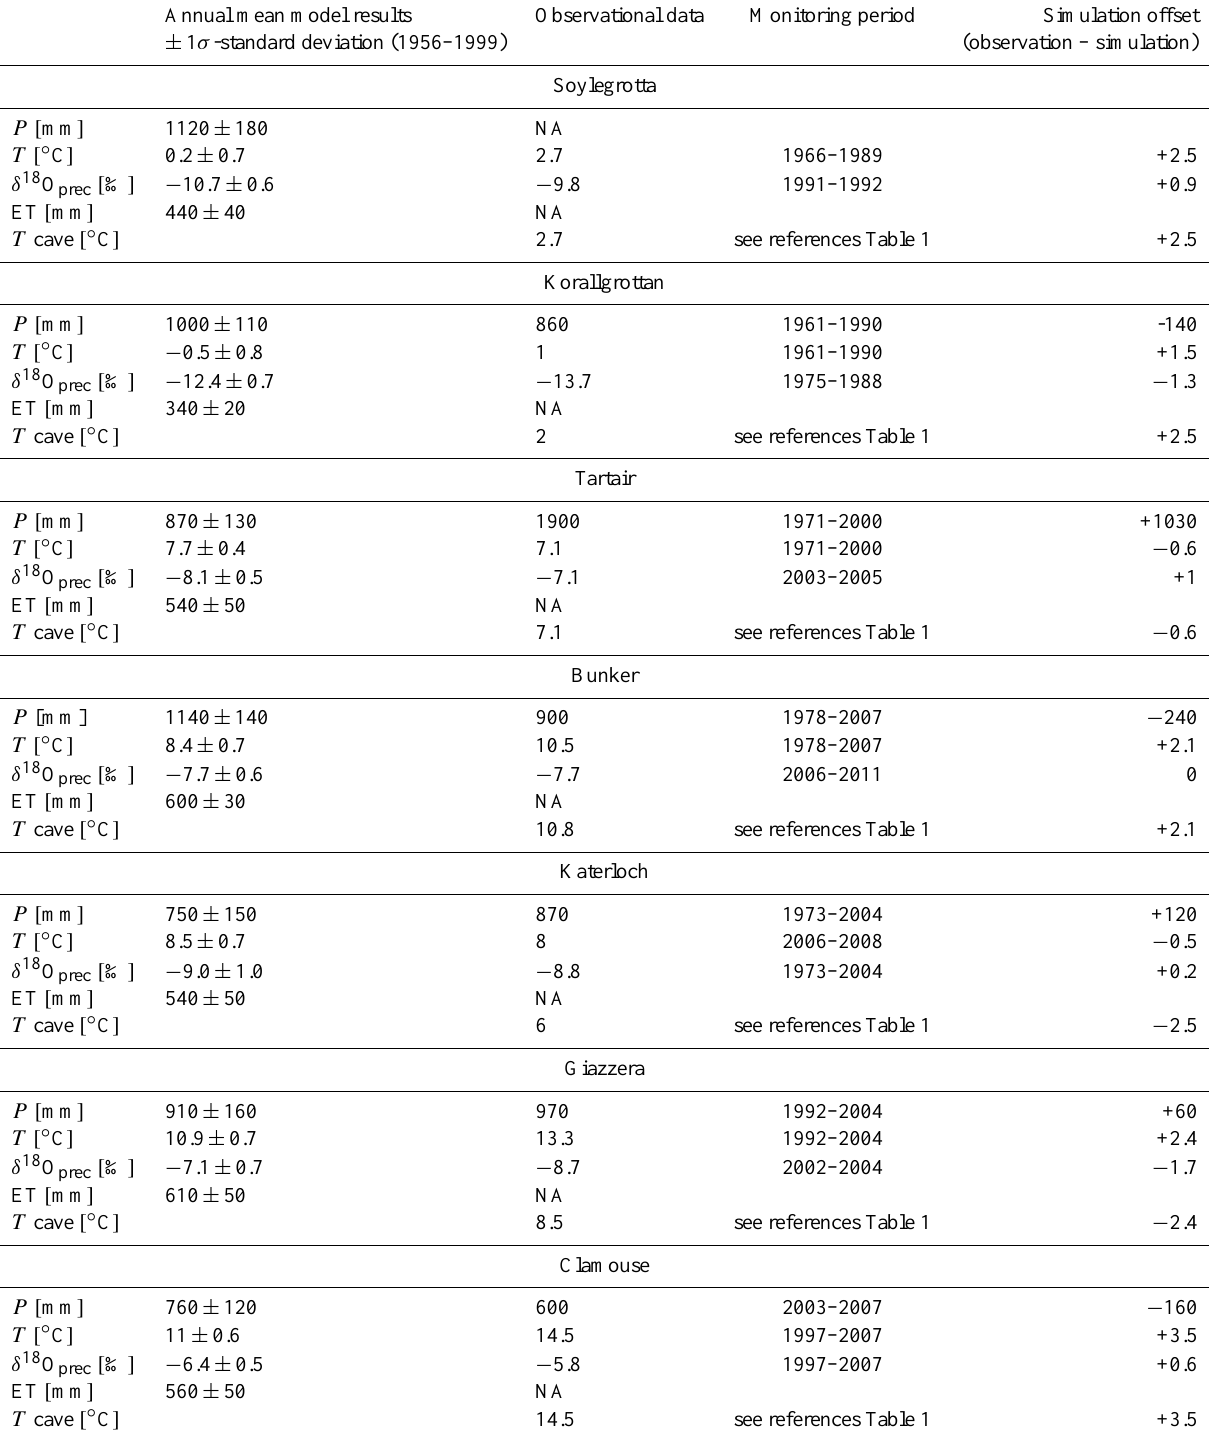
Table 2. Compilation of ECHAM5-wiso results and observational climate data for each cave. The last column shows the difference between modelled and observed